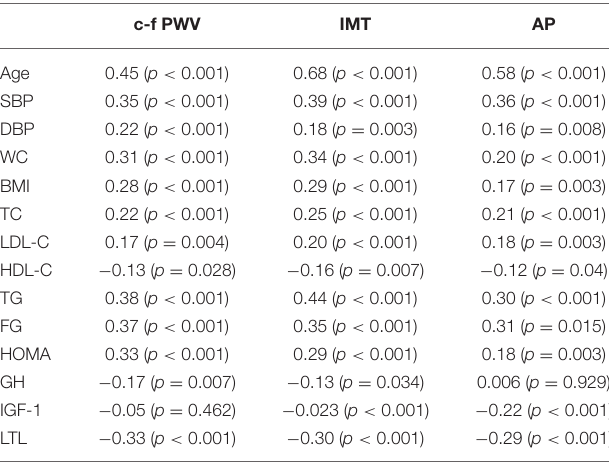
TABLE 3 | Association between the arterial wall parameters and studied indicators in the general group.